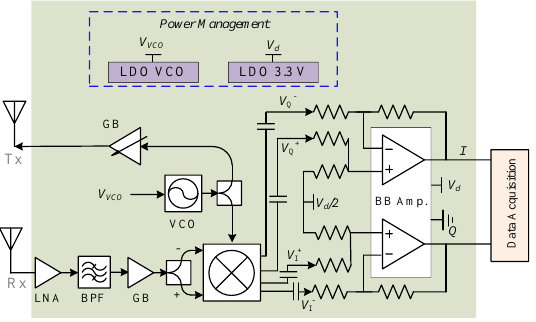
Figure 12. Block diagram of the 2.4 GHz Doppler radar integrated on the printed circuit board (as shown in the shaded area).